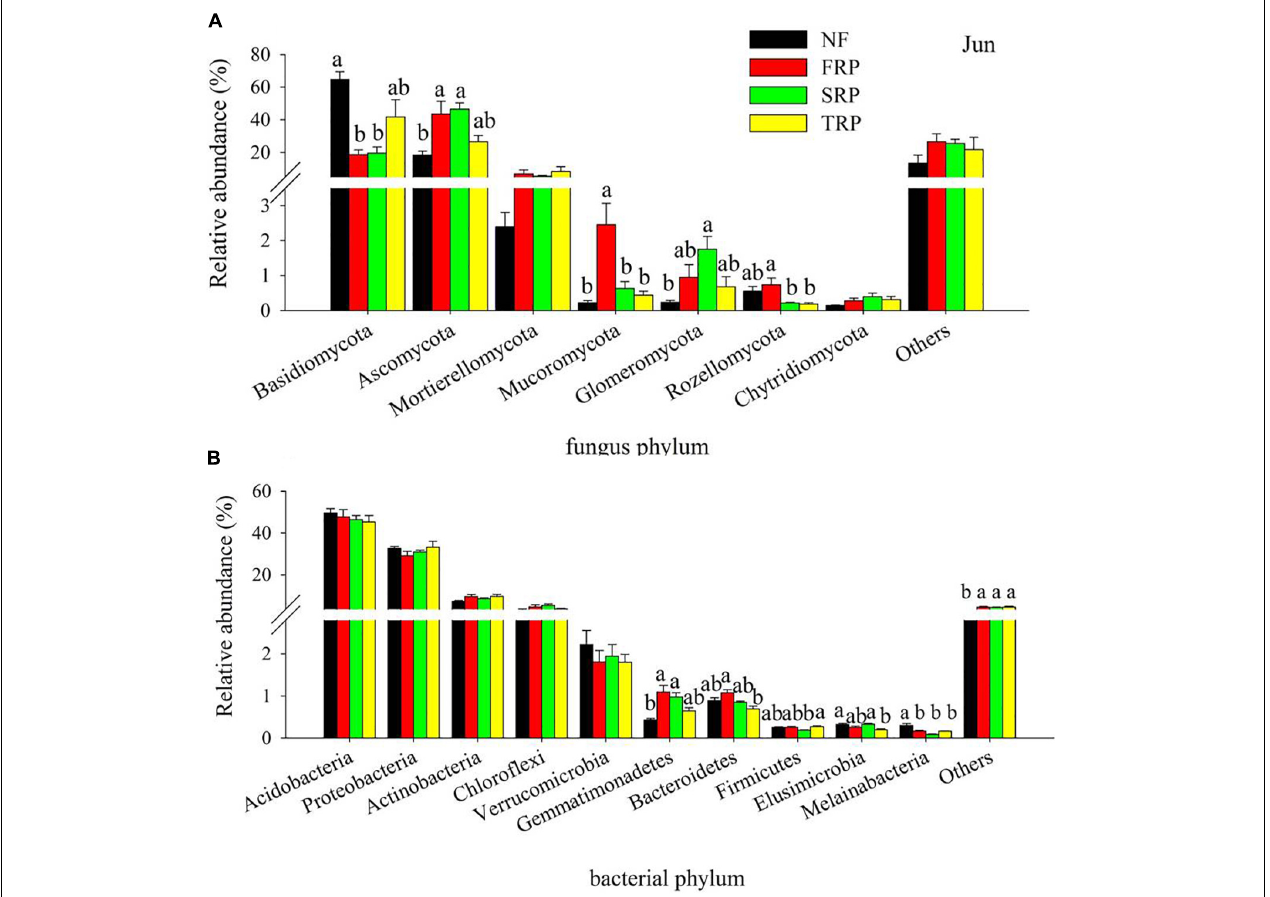
FIGURE 1 | Relative abundance of the most abundant fungal (A) and bacterial (B) groups in different plantations in June at the phyla level. Others represented unclassified groups. Data are means ± standard error ( n = 4). Significant differences are indicated with distinct letters. NF, natural forest; FRP, first rotation plantation; SRP, second rotation plantation; TRP, third rotation